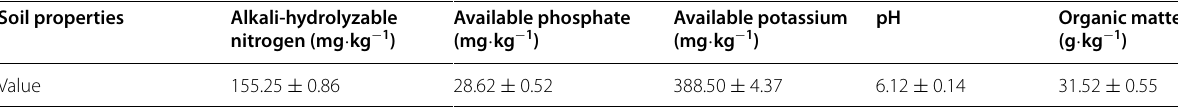
Table 1 Physicochemical properties of the soil (10–30 cm soil layer) Soil properties